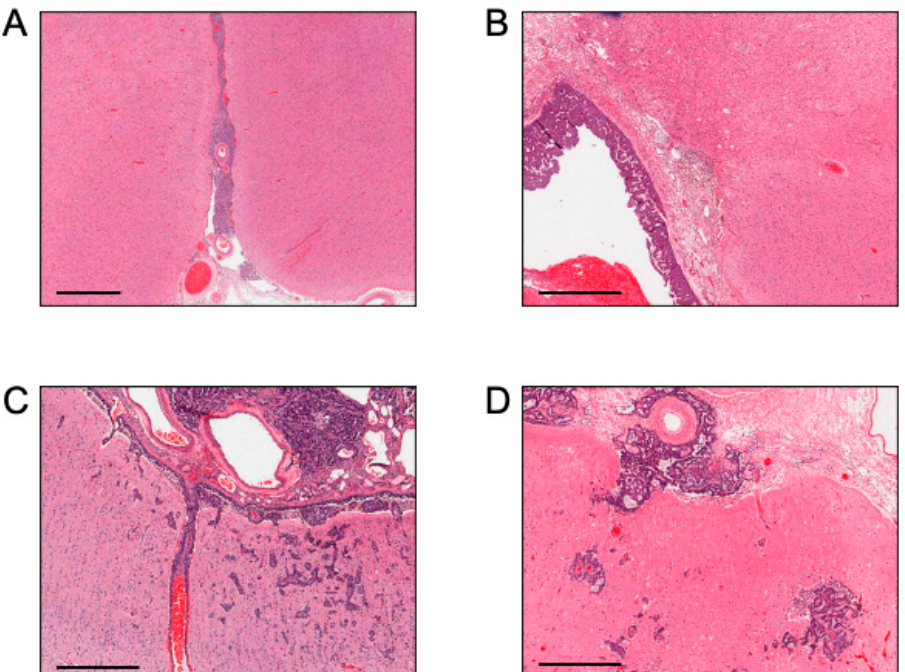
Figure 2. Different appearances of leptomeningeal metastasis (LM) by histopathology in lung cancer patients. H&E stains demonstrating cancer cells ( A , B ) exclusively in the subarachnoid space and ( C , D ) in the subarachnoid space with communication of cancer cells with the brain parenchyma through local invasion. Scale bars: 1 mm.